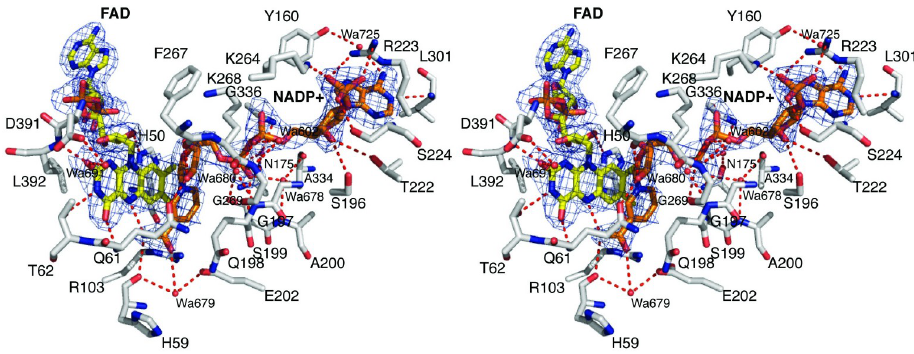
Fig 9. Active site environment of Ss DesB-NADP + bound structure. Stereo-view of the active site of the Ss DesB-NADP + bound structure (PDB code: 6XBB). The fit of the FAD molecule (carbon atoms in yellow, nitrogen atoms in blue, oxygen atoms in red, and phosphate atoms in orange) and the NADP + molecule (carbon atoms in orange) to the final 2 F electron density map is shown (blue mesh, 2.37 Å resolution, contoured at 1 σ level). o -F c